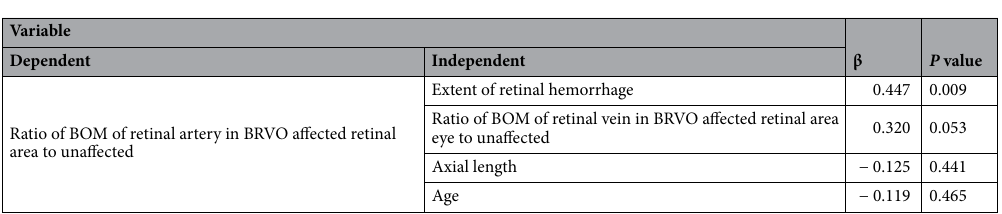
Table 5. Results of multiple regression analysis for independence of factors contributing to ratio of BOM of retinal artery in BRVO affected retinal area to unaffected.